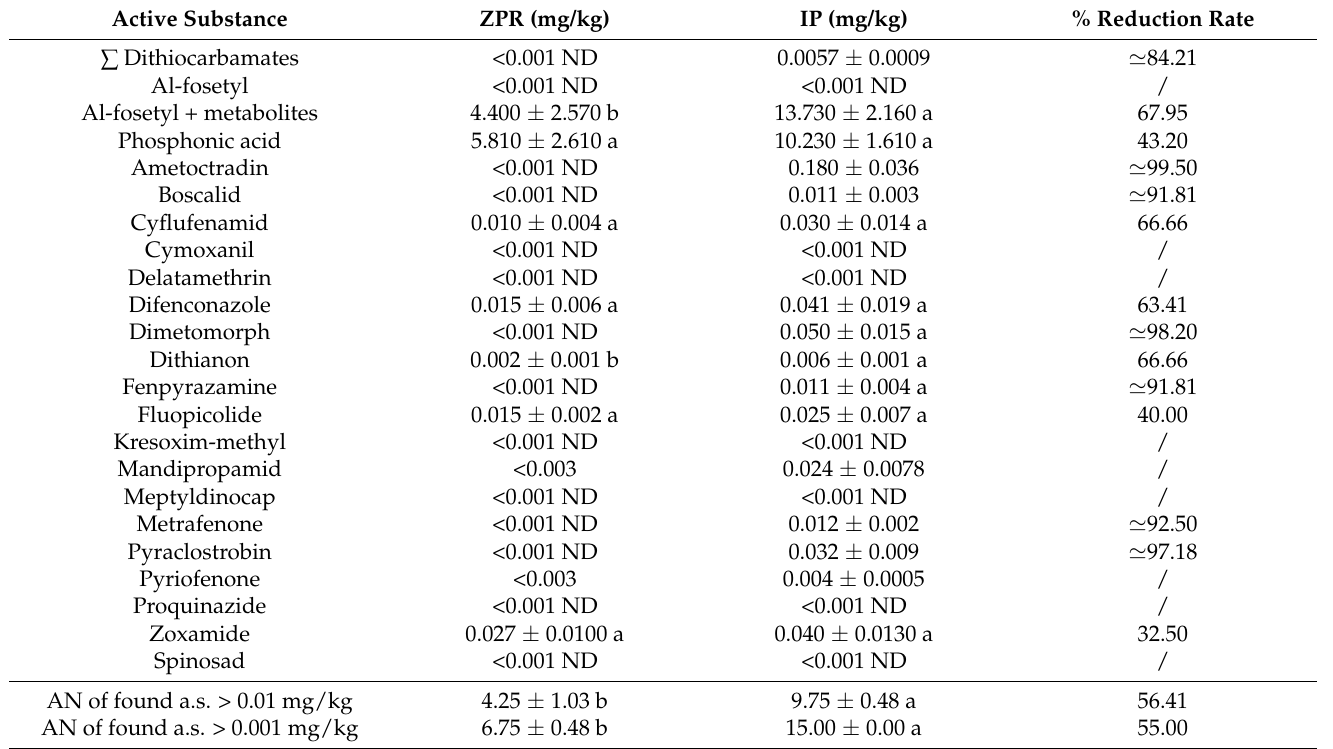
Table 11. Average concentration (mean ± SE) of pesticide residues in Merlot grapes. A result of <0.001 ND means that a.s. was not detected at level higher than 0.001 mg kg − 1 . /—concentration reduction rate and significance of difference between IP (integrated) and ZPR (0-pesticide residue) means cannot be calculated. Pesticide concentration reduction rate (%) = 100 − ((ZPR/IP) × 100) (see explanation in Section